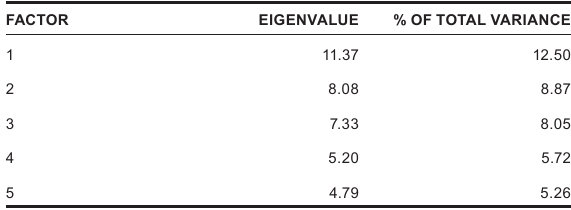
Table 1 Factor analysis: Validity of the instrument measuring the dimensions of TQM